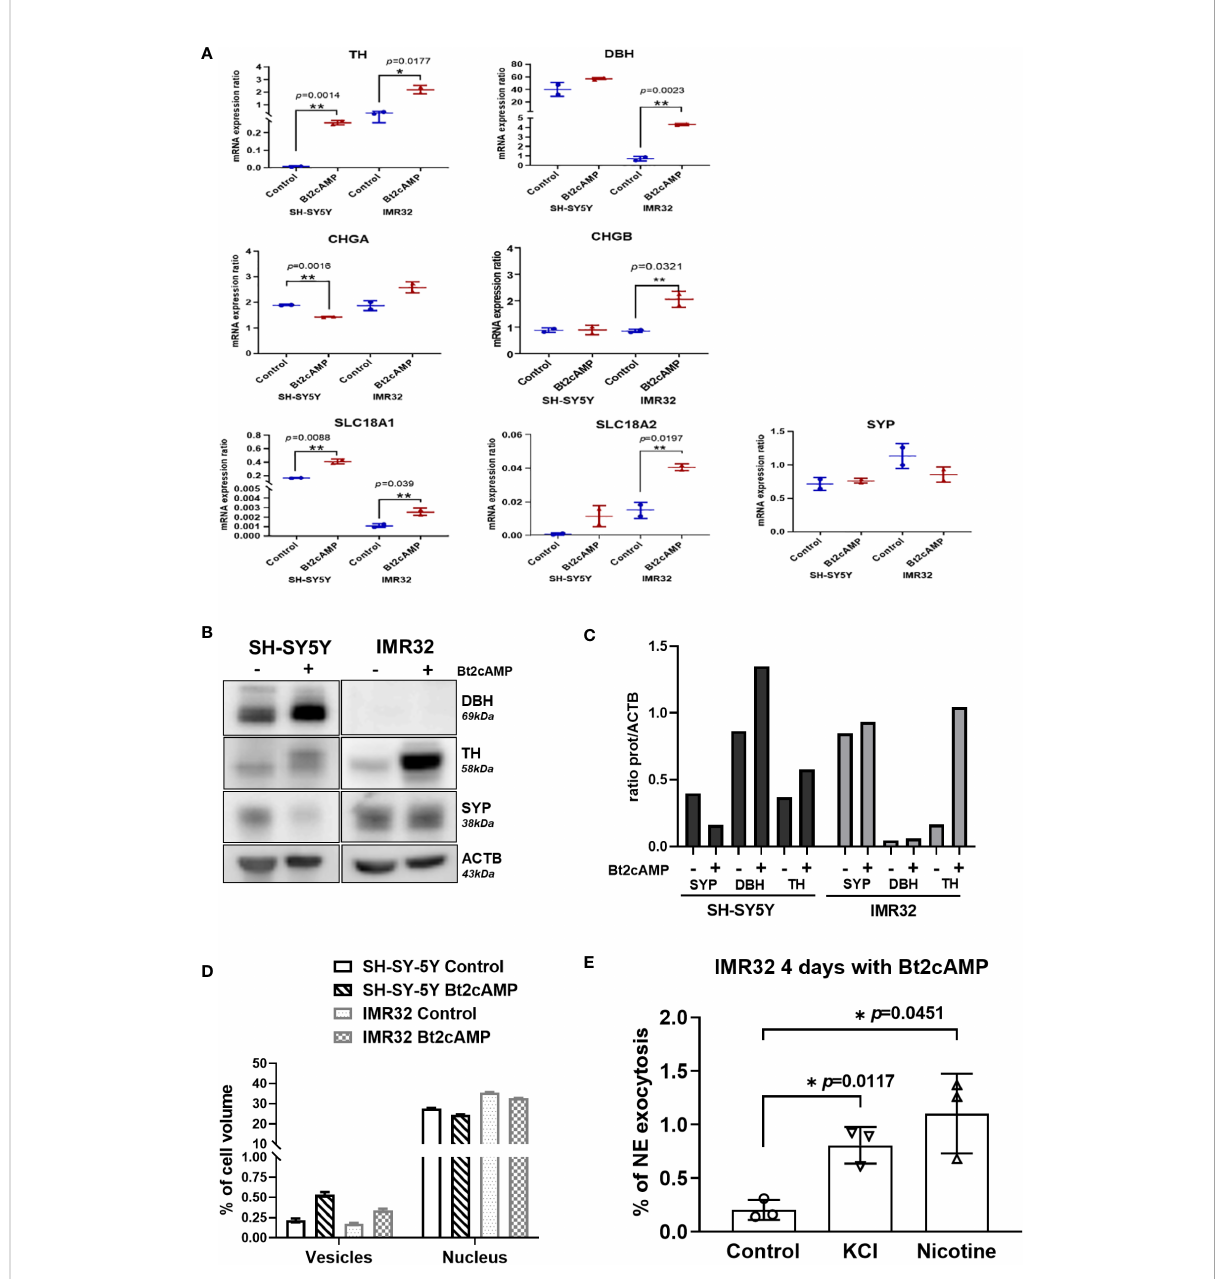
FIGURE 6 NV induction and exocytosis in cAMP treated cells. (A) mRNA quanti fi cation of TH, DBH, CHGA, CHGB, SLC18A1, SLC18A2 and SYP in SH-SY5Y and IMR32 cell lines treated without (Control) and with 500nM Bt2cAMP for 4 days. Fold change: TH: 42.6 in SH-SY5Y and 6 in IMR32, DBH: 1.42 in SH-SY5Y, 6.2 in IMR32, CHGA: 0.75 in SH-SY5Y and 1.38 in IMR32, CHGB: 1.5 in IMR32 cells, SLC18A1: 2.5 in SH-SY5Y and 2.3 IMR32; SLC18A2: 12.8 in SH-SY5Y and 2.7 in IMR32. Assays were performed in triplicate and individual values and means ± SD are plotted and analyzed with an unpaired t-test. p values are reported only when statistically signi fi cant (<0.05). *= p <0.05, **= p <0.01. (B) Immunoblotting for SYP, DBH and TH expression in cells treated as in (A, C) Quanti fi cation of immunoreactive signal normalized with ACTB protein expression using the Image J software. (D) Bare graph representing the counting of NVs (vesicles) and nucleus volume per cell using stereologic method on 2 fi elds of 120x120 µm per condition (approx. 30 and 40 cells/ fi elds for SH-SY5Y and IMR32 cells, respectively). (E) Quanti fi cation of NE following chemical stimuli (56mM KCl or 100 µM nicotine) from IMR32 cells incubated 4 days with 500 nM Bt2cAMP. Values are expressed in % of NE found in cell medium regards to total NE (cytoplasmic plus cell medium concentrations). NE: values for control, KCl and nicotine: 0.2, 0.81 and 1.1% respectively. Assays were performed in triplicate and individual values and means ± SD are plotted and analyzed with a Welch ’ s t-test. *= p